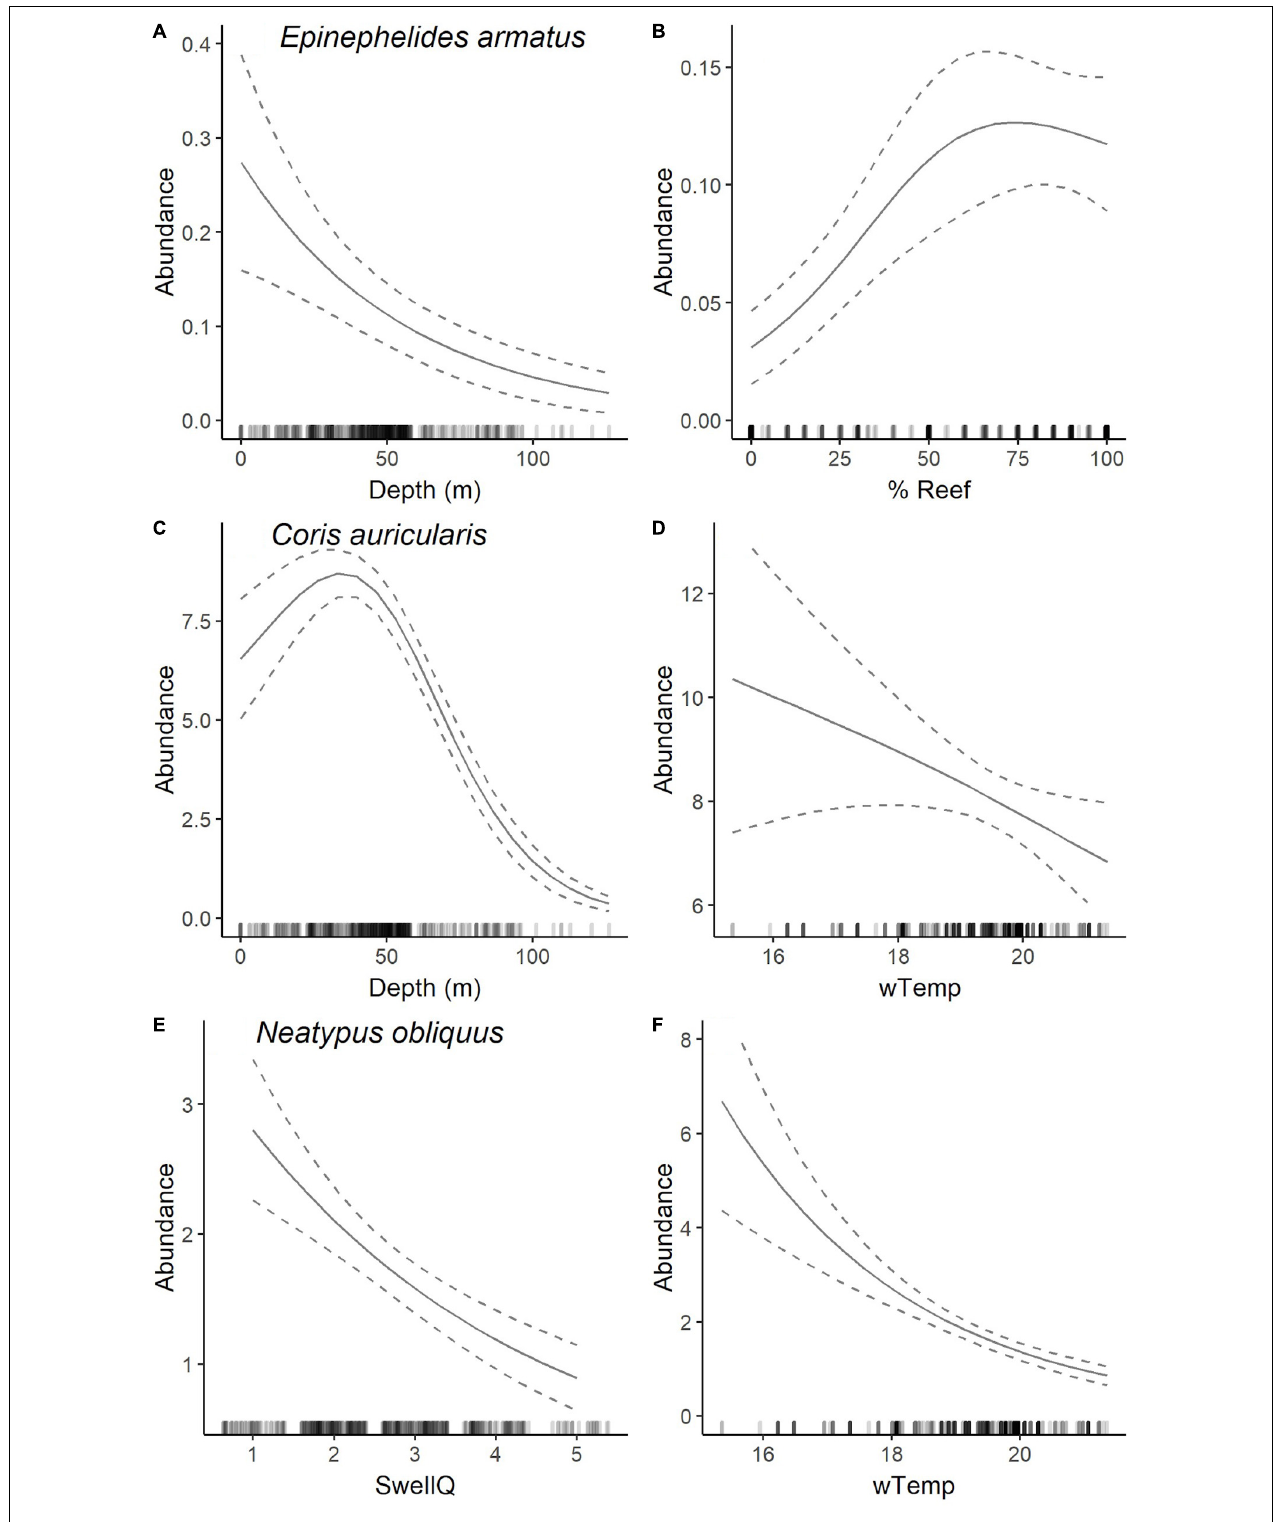
FIGURE 5 | Plots of most parsimonious model found to predict the abundance distribution of E. armatus (A,B) , C. auricularis (C,D) , and N. obliquus (E,F) from full subset GAM analyses (see Table 2 ). Solid lines are fitted gam curves, with dashed lines indicating standard error confidence bands; rug plot is used to indicate the distribution of